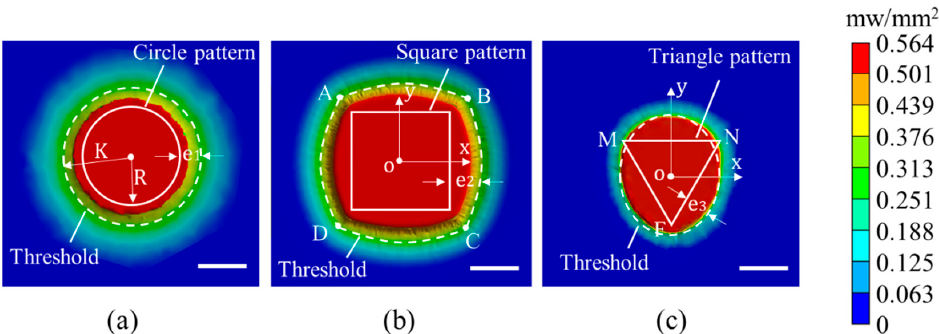
Figure 3. The simulation results for the power intensity distribution. ( a ) The circle pattern with a diameter of 100 µm, ( b ) the square pattern with a length of 100 µm and ( c ) the regular triangle pattern with a length of 100 µm. Scale bar: 50 µm.